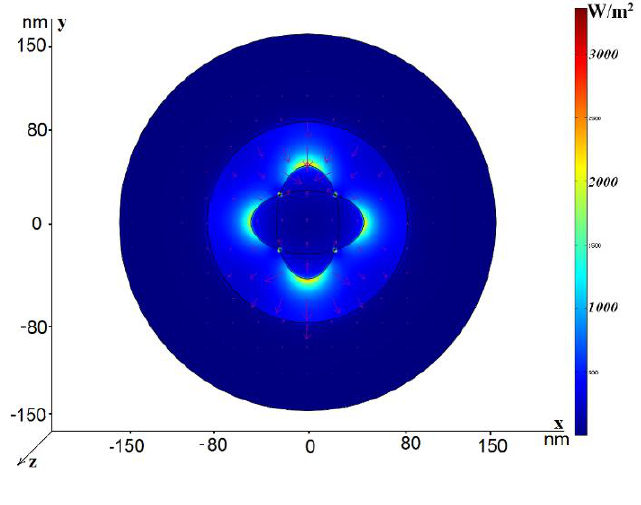
Figure 8. Power flow distribution for the dipole-like mode in the case R h = 80 nm; the large ellipse semi-axis is 45 nm and the small ellipse semi-axis is 25 nm. 2 n = 2.396 + i0.045. eff